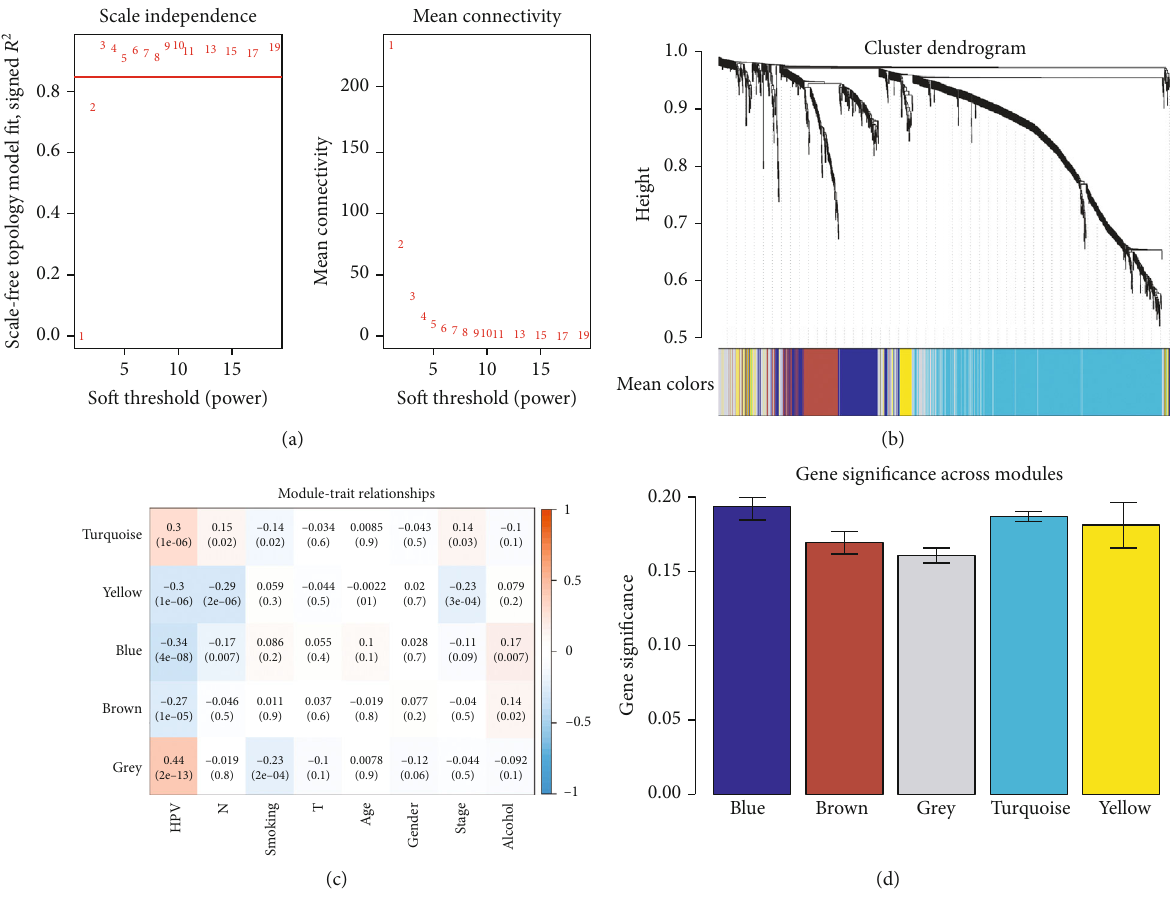
Figure 4: Weighted IRDEGs of the HNSCC expression network. (a) The scale-free fi t index for soft-thresholding powers. The soft- thresholding power in the WGCNA was determined based on the scale-free R 2 ( R 2 = 0 : 85 ). The left panel presents the relationship between the soft threshold and the scale-free R 2 . The right panel presents the relationship between the soft threshold and mean connectivity. (b) A dendrogram of the di ff erentially expressed genes clustered based on di ff erent metrics. Each branch in the fi gure represents one gene, and the color below it represents one expression module. (c) Heatmap showing the correlation between the gene module and clinical traits. The turquoise module contained 596 IRGs, while the blue module contained 186 IRGs. The correlation coe ffi cient in each cell represents the correlation between gene module and clinical traits, which decrease in magnitude from red to blue. The turquoise module showed the highest positive correlation with survival, while the blue module showed the highest negative correlation with survival. (d) Distribution of average GS and errors in the modules associated with the overall survival of HNSCC patients. Based on the average linkage hierarchical clustering and the soft-thresholding power, six modules were identi fi ed. To determine the signi fi cance of each module, GS was calculated to measure the correlations between genes and sample traits. GS was de fi ned as the log 10 p ). The turquoise and blue modules conversion of the p value in the linear regression between gene expression and clinical data ( GS = log 10 showed high correlations with the survival of HNSCC